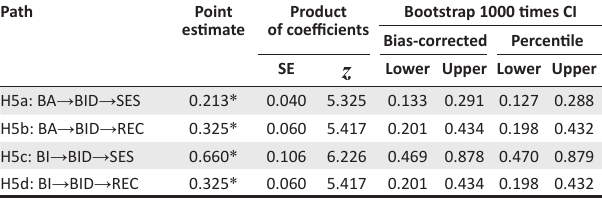
TABLE 5: Bootstrap method and verification results. Path Point